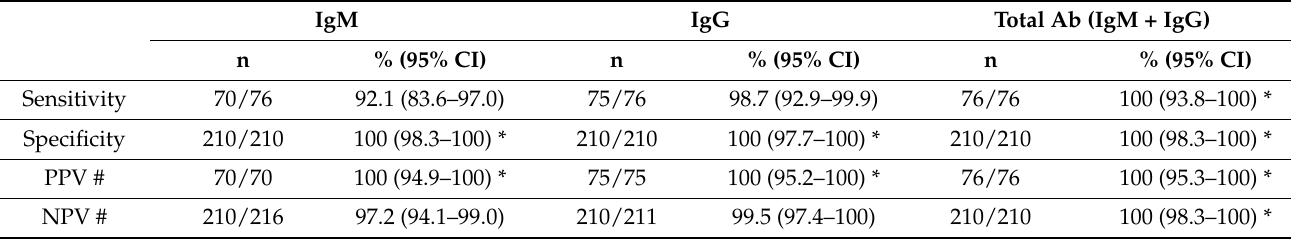
Figure 1. Specificity of the COVID-19 SIA. ( A ) Results for anti-S1 IgM. ( B ) Results for anti-S1 IgG. The control panel included sera from blood donors, infants, patients with acute Epstein-Barr virus (EBV) infection, and patients/convalescents with COVID-19. The dashed line indicates the assay cut-off of 300 MFI and the vertical line the median. MFI, median fluorescence intensity; Ig, immunoglobulin; COVID-19, Coronavirus disease 2019; SIA, suspension immunoassay; S1, spike subunit 1. Table 4. Evaluation results of the COVID-19